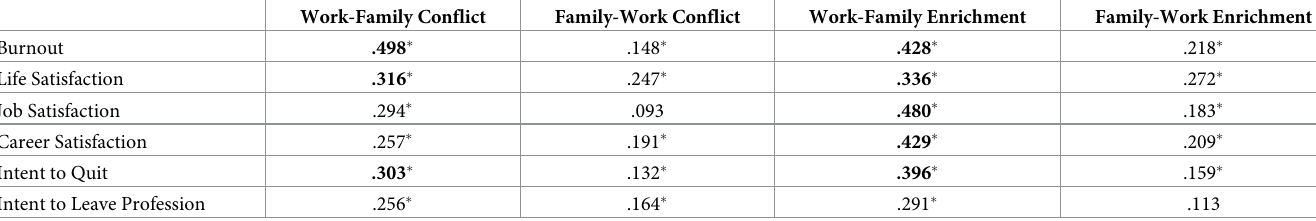
Table 2. Correlative relationships of conflict and enrichment scores for registered dietitian nutritionists.